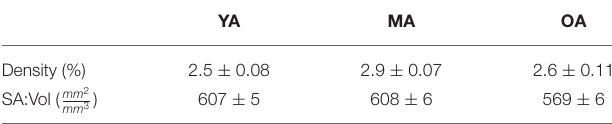
TABLE 3 | Quantified mean and variation of model oxygen